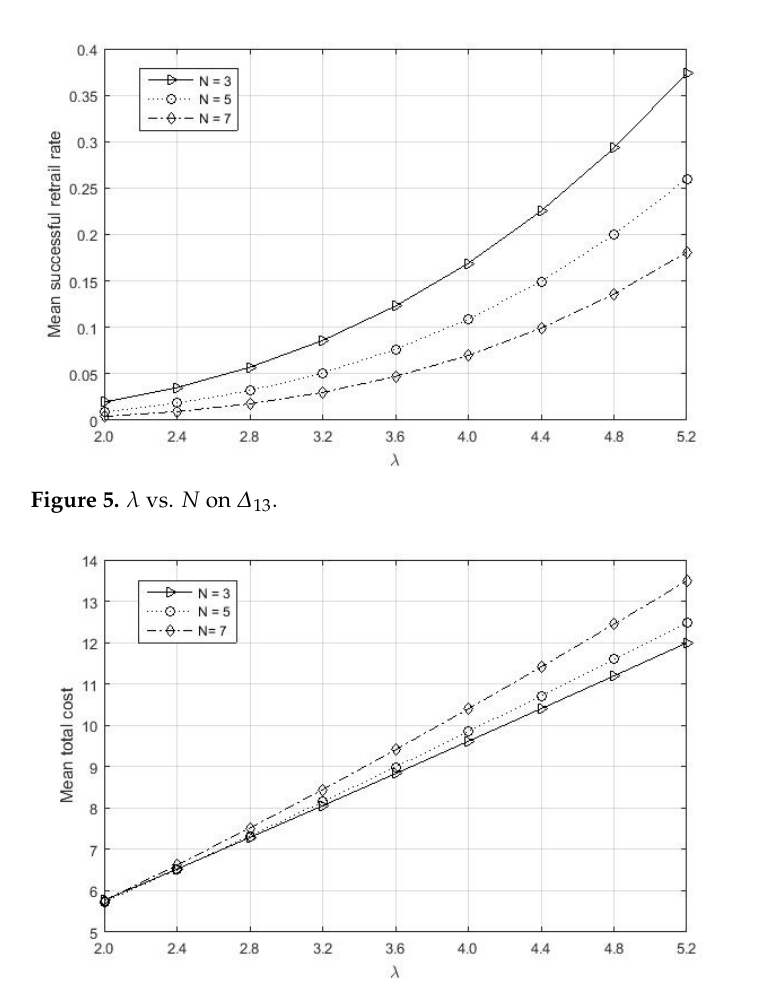
Figure 6. λ vs. N on MTC